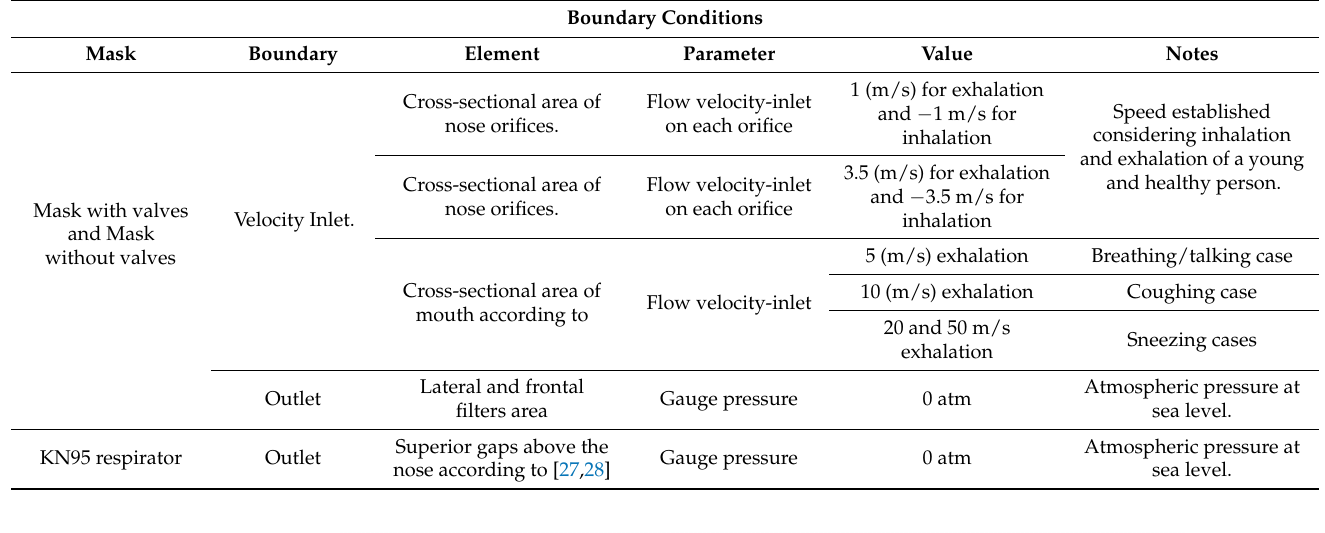
Table 1. Boundary conditions and main parameters considered in the mask simulation.